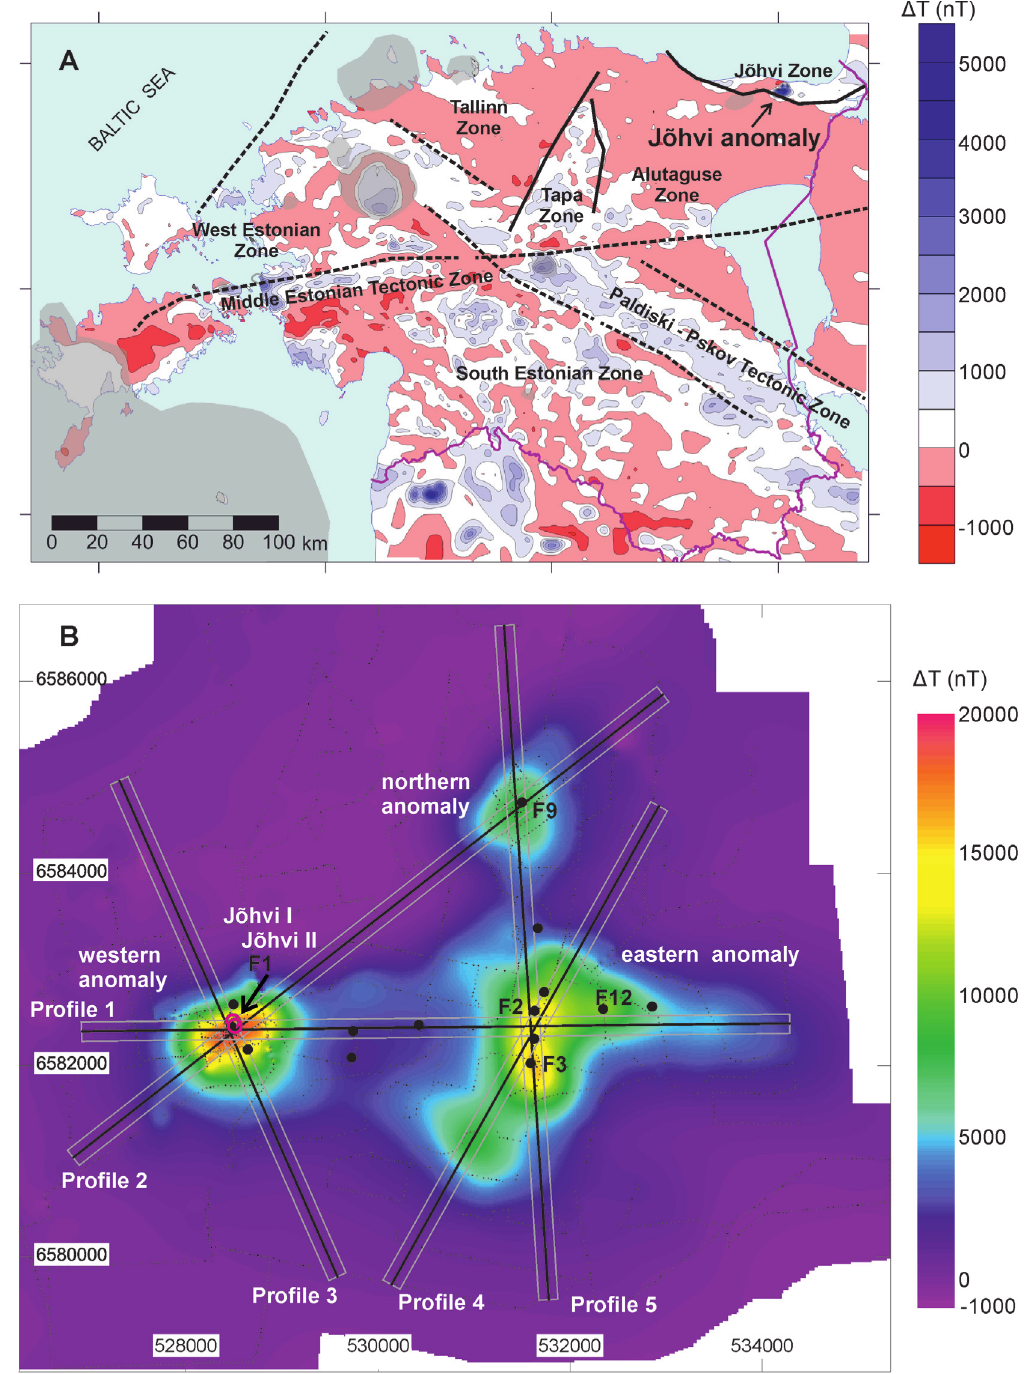
Fig. 1. A , structural features and metamorphic complexes of the Precambrian basement compared to aeromagnetic anomaly maps. Grey areas represent anorogenic complexes of rapakivi and related granites; the rest are Svecofennian metamorphic and plutonic rocks. Geological data are after Puura et al. (1997) and Bogdanova et al. (2015). The aeromagnetic overview map is by the Geological Survey of Estonia. The Jõhvi anomaly within the Jõhvi Zone in NE Estonia is indicated. B , total magnetic intensity anomaly map of the Jõhvi anomaly based on the year 2019 measurements. Shown are the profiles for magnetic modelling and location of drill holes (black dots). Drilling was performed in the late 1930s (Jõhvi I and II in the centre of the western anomaly) and 1960s (rest of the holes marked). Physical properties of the Jõhvi series cores only were measured during the present study, whereas the rest has perished. Small black marks show the individual measurements. Coordinates are in the UTM zone